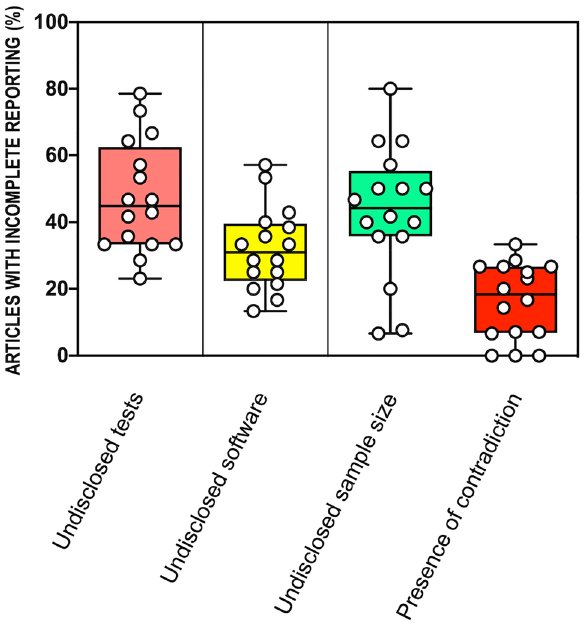
Figure 1. Quantification of primary binary outcomes. The Y axis displays the percentage of articles with incomplete reporting in each journal, each dot represents one journal (k = 16). Box plots represent interquartile range (box) and range